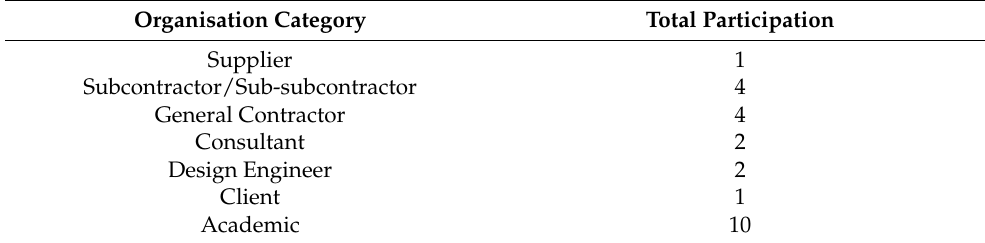
Table 2. Classification of expert forum